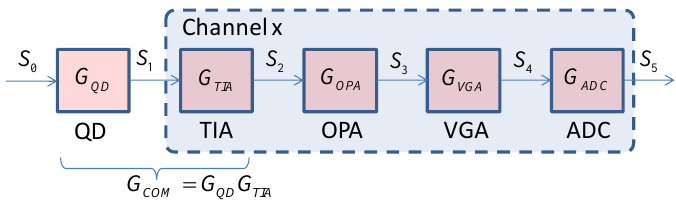
Figure 4. The gain model of QD and its signal processing chain in a channel.